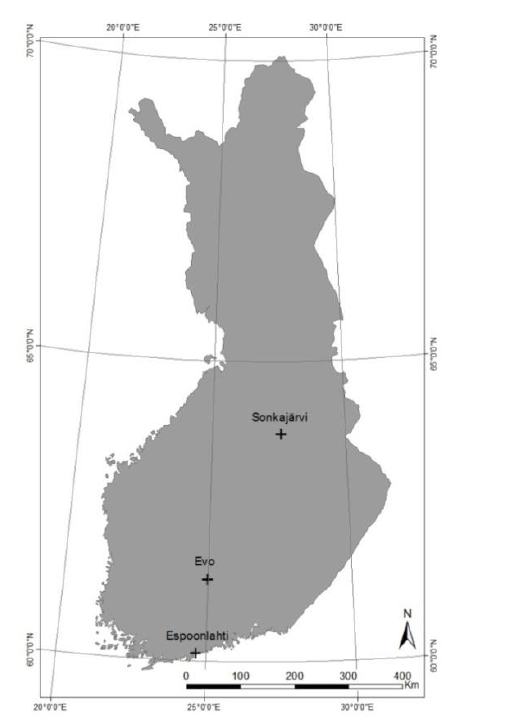
Figure 1. Locations of the study sites.